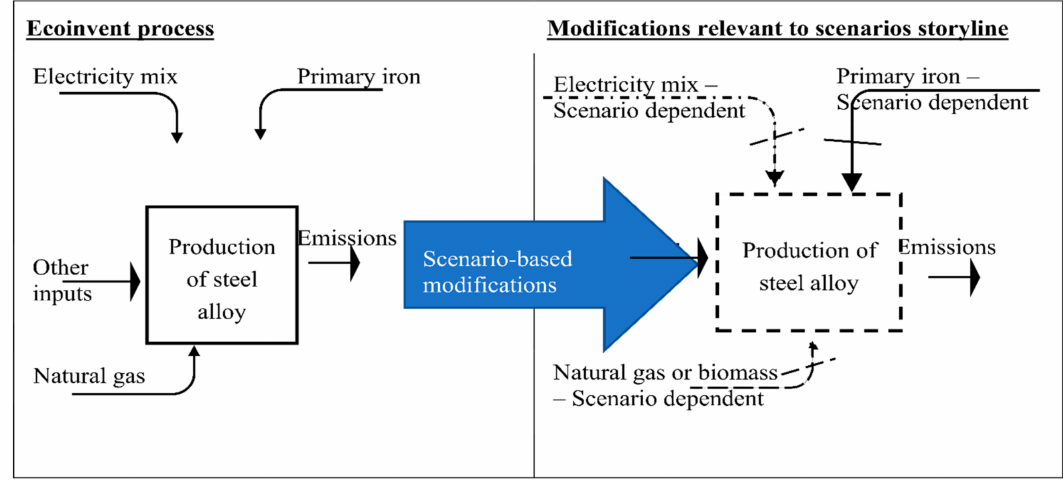
Figure 4. Schematic representation of processes for producing steel alloys, and process parameters that were modified for consistent scenario evaluation. Solid boxes indicate an original Ecoinvent process, solid arrows indicate original Ecoinvent values. The box with a dashed line indicates a modified or new process for this study, crossed arrows with dashed lines indicate that either one of or both the process and values were modified in line with the scenario, and crossed arrows with solid lines shows that only the processes were